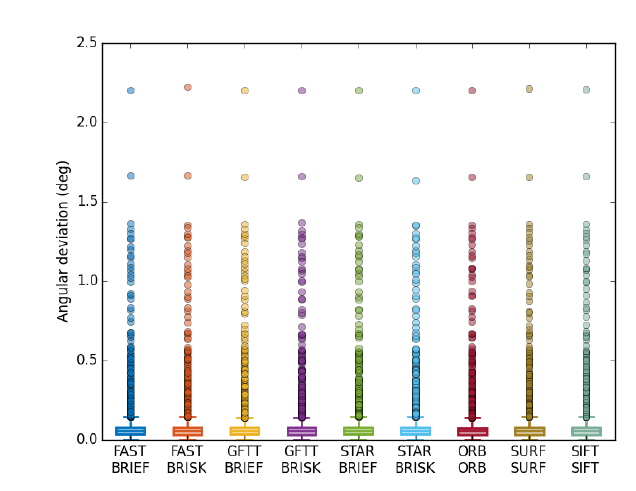
Figure 5. Relative orientation